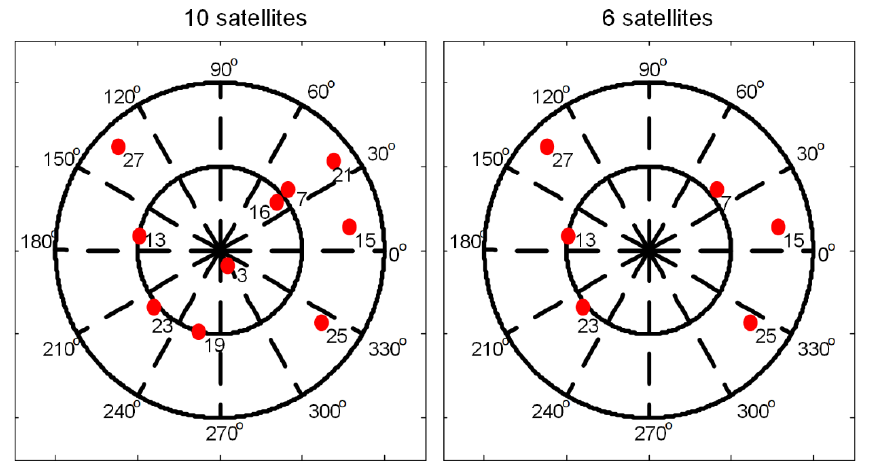
Remote Sens. 2019 , 11 , x FOR PEER REVIEW